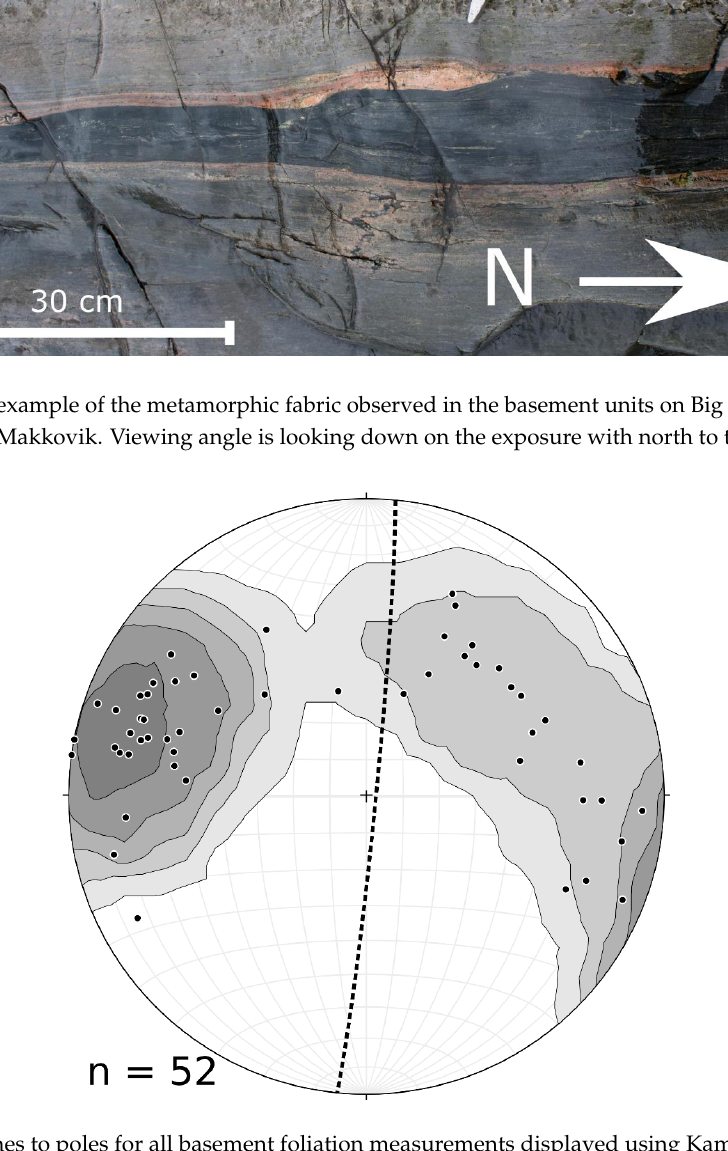
Figure 5. Planes to poles for all basement foliation measurements displayed using Kamb contouring. The contour interval is 2 σ , and the counting area is 14.8% of the Stereonet. Folding is shown by this dataset, with the dominant structural trend of the limbs dipping to the east and west. The axial plane is shown with a dashed line (005/87 E: strike, dip, dip-direction) that was calculated in the